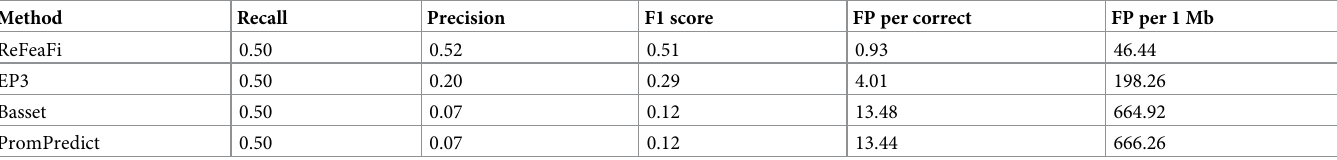
Table 1. Comparison of the performance of different TSS identification methods. The decision thresholds for these methods were adjusted to achieve the same recall of 0.50. Method Recall Precision